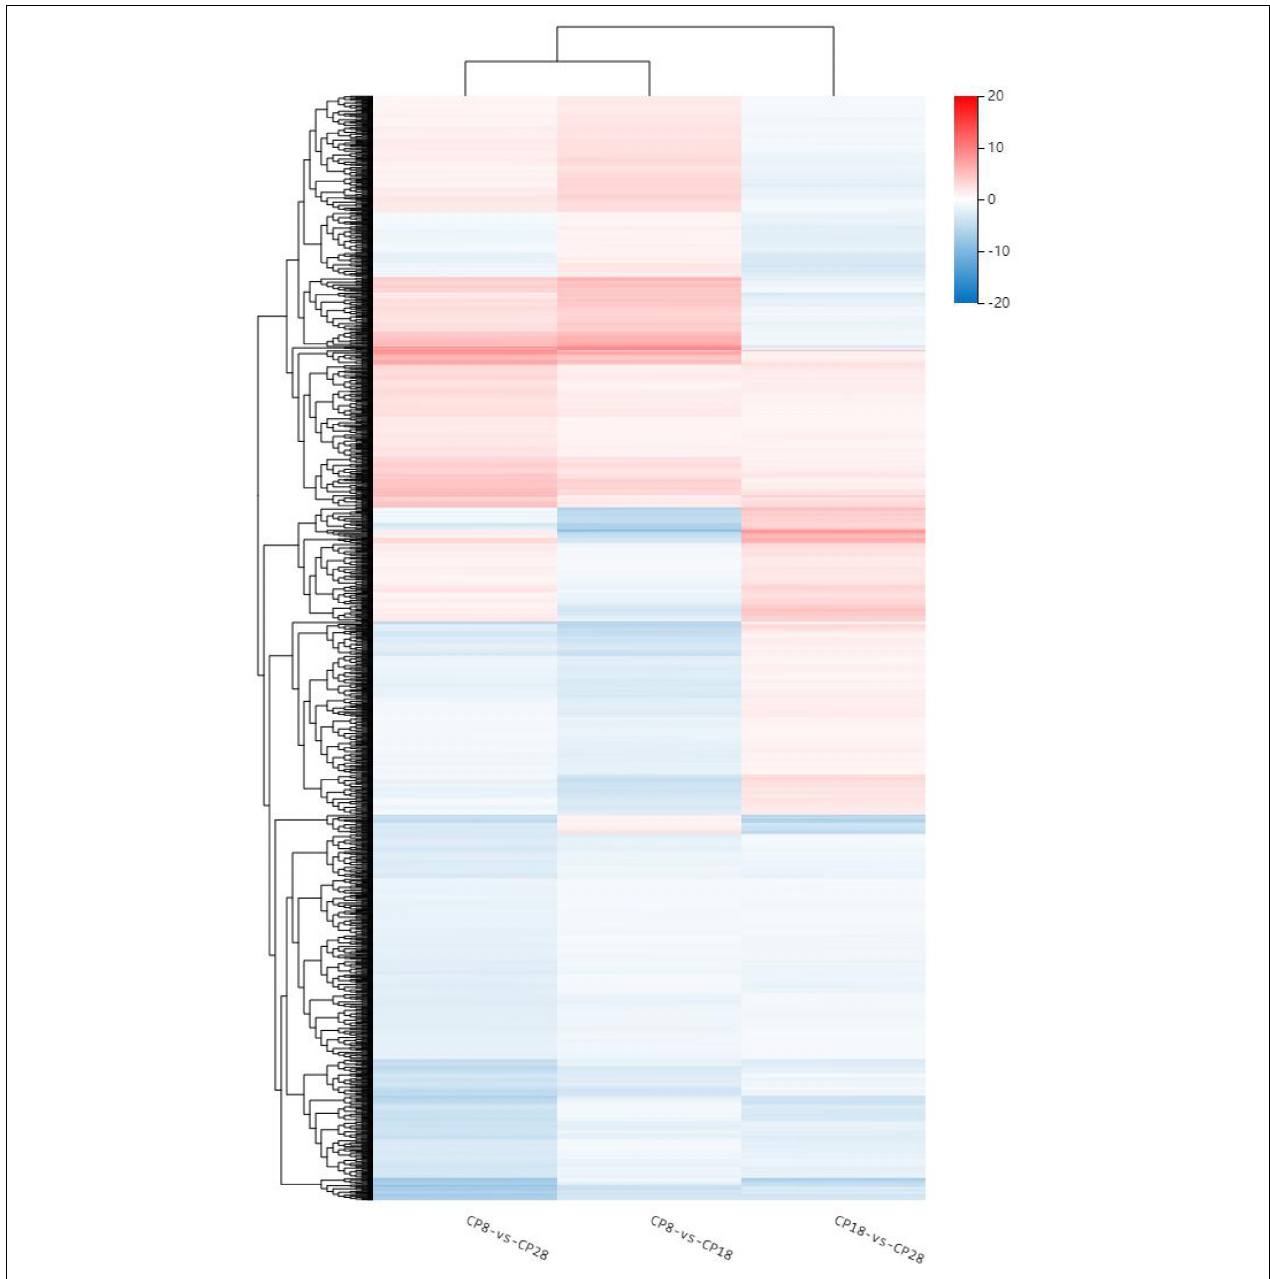
FIGURE 4 | Heatmap of GO cluster of 2,099 DEGs in the seed coat of hulled C. pepo